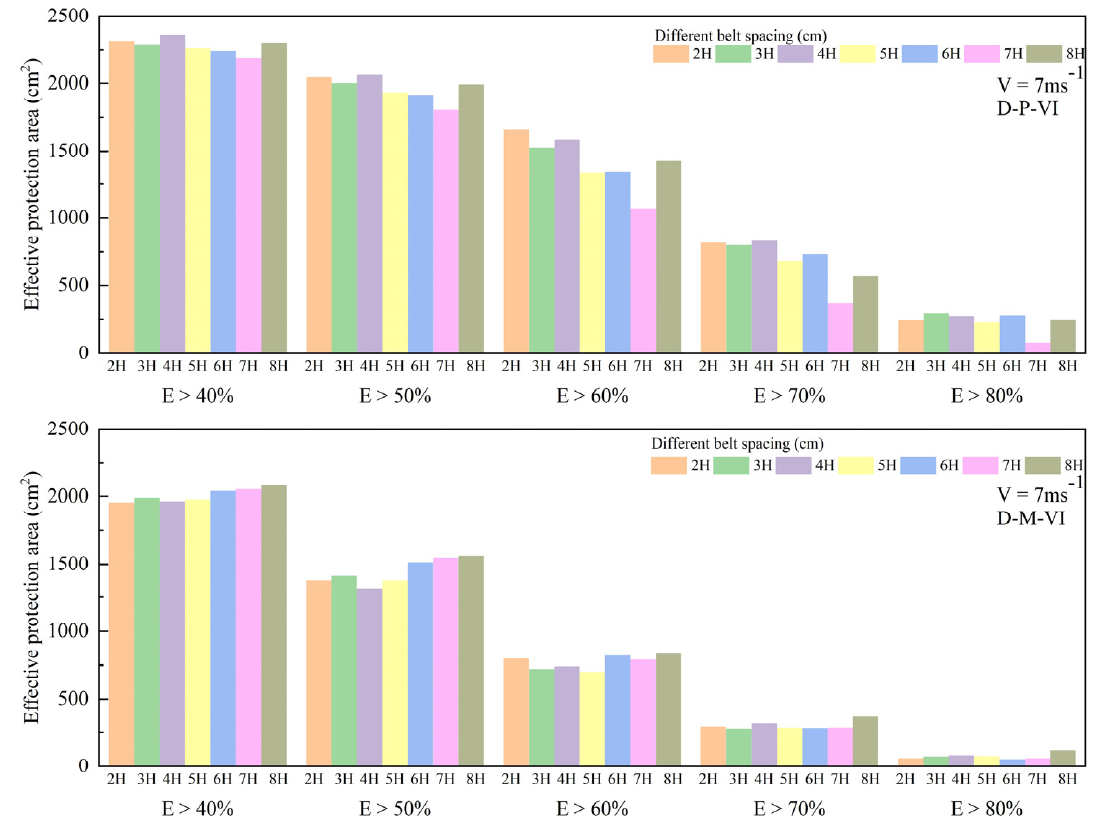
Figure 10. Effective protection area of double shelterbelts in the range of 0H–8H behind the shelterbelt at a vertical height of 0H–3H. The abscissa represents the shelterbelt with different belt spacings under a certain shelter efficiency. For example, “6H–50%” indicates a protection forest with a shelter efficiency of ≥ 50% and belt spacing of 6H. The ordinate represents the effective protection area (cm 2 ). 3.2.3. Effective Protection Ratio of Double Shelterbelts (between the Shelterbelts) Comparing the effective protection ratio between the shelterbelts of the D-P-VI and D-M-VI protective forests, it can be concluded that the wind protection ability of the D- M-VI protective forest was superior to that of the D-P-VI protective forest under the same shelter efficiency and belt spacing (Figure 11). Figure 11 shows that the effective protection ratio between the shelterbelts of the D-P-VI protective forest with different belt spacings varied little under the same shelter efficiency and the difference between shelterbelts of the D-M-VI protective forest was even smaller. For example, when the shelter efficiency was 50%, the effective protection ratio between shelterbelts of the D-P-VI protective forest varied from 41.89% to 49.74%, whereas that of the D-M-VI protective forest varied from 56.22% to 57.11%. When the shelter efficiency was 60%, the range of variation was 33.42–41.01% for the D-P-VI protective forest compared to 50.69–53.03% for the D-M-VI protective forest. For the D-M-VI protective forest, the effective protection ratio between the strips of the protection forest showed a decreasing trend with the increase in the belt spacing under the same shelter efficiency. However, the D-M-VI protective forest maintained a good protection effect when the belt spacing was increased to 8H. For example, when the shelter efficiency was 70%, 40.08% of the area between the shelterbelts can reach over